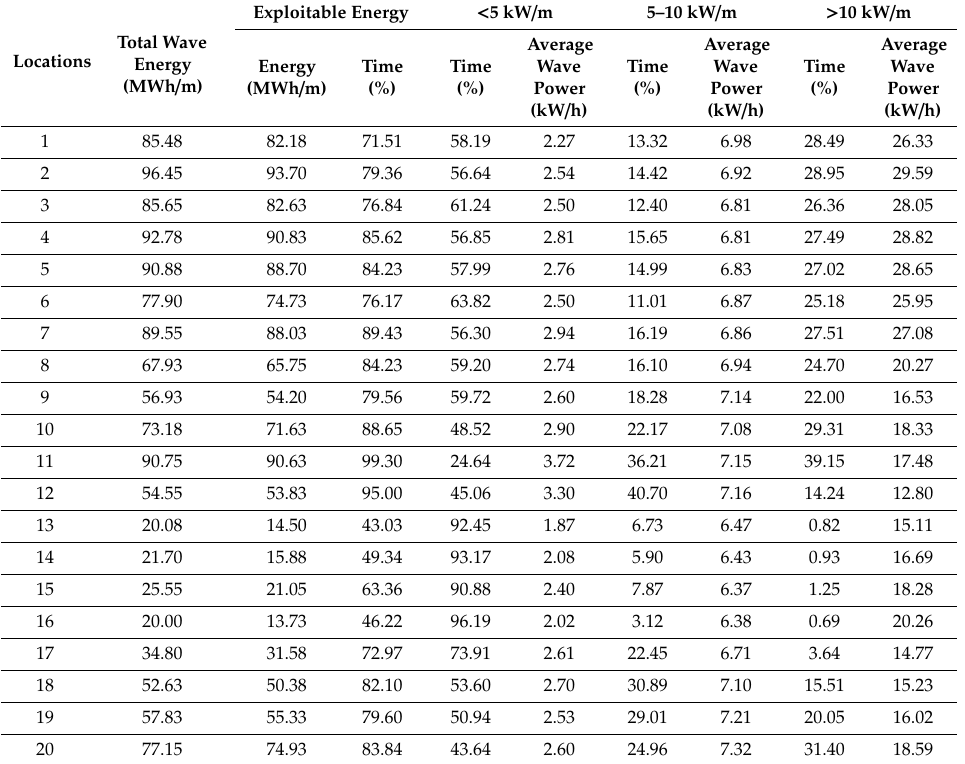
Figure 6. Monthly average values of wave power at different locations. Left panel is for locations in the western shelf seas of India and the right panel is for the eastern shelf seas. Table 2. Percentage of time the wave power is available in di ff erent ranges for all locations studied. Total and exploitable storage of wave energy (kWh / m) are also presented. The values presented are the annual average for 40